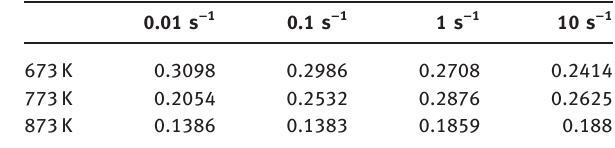
Figure 12. Accordingly, the explicit functions of f 2 ð _ ε , T Þ and f 3 ð _ ε , T Þ are achieved and expressed as eqs (12) and (13) respectively and the relevant coefficients are listed in Table 7. Similarly, the analysis of variance for f 2 ð _ ε , T Þ and f 3 ð _ ε , T Þ (as shown in Table 8) was calculated to